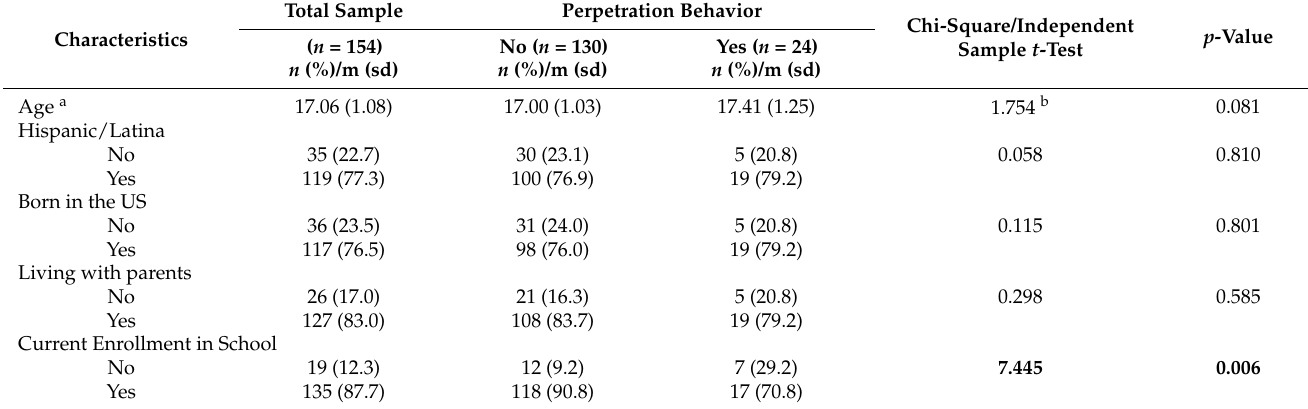
Table 1. Sociodemographic Characteristics of